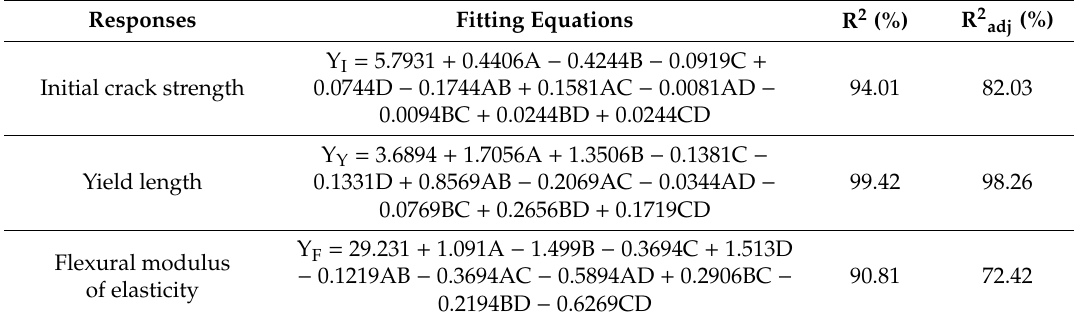
Table 6. Fitting equations of each